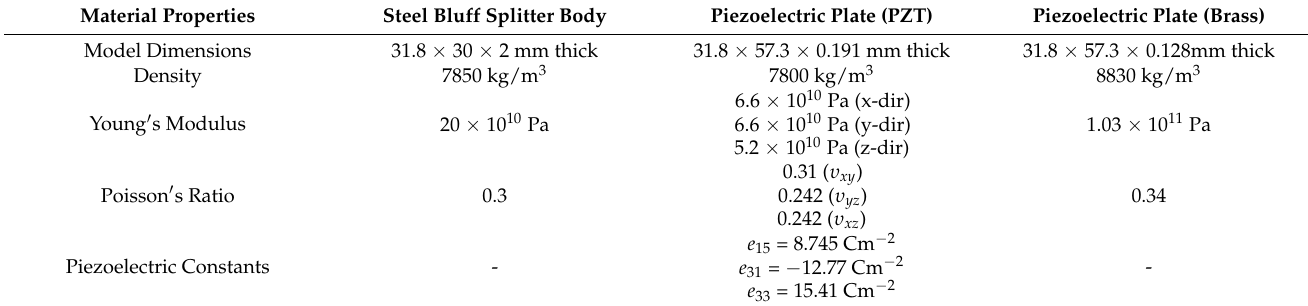
Figure 8. Resonant frequency and corresponding mode shape of PVEH plate under cantilevered boundary condition. Table 4. Material properties of PVEH plate model.